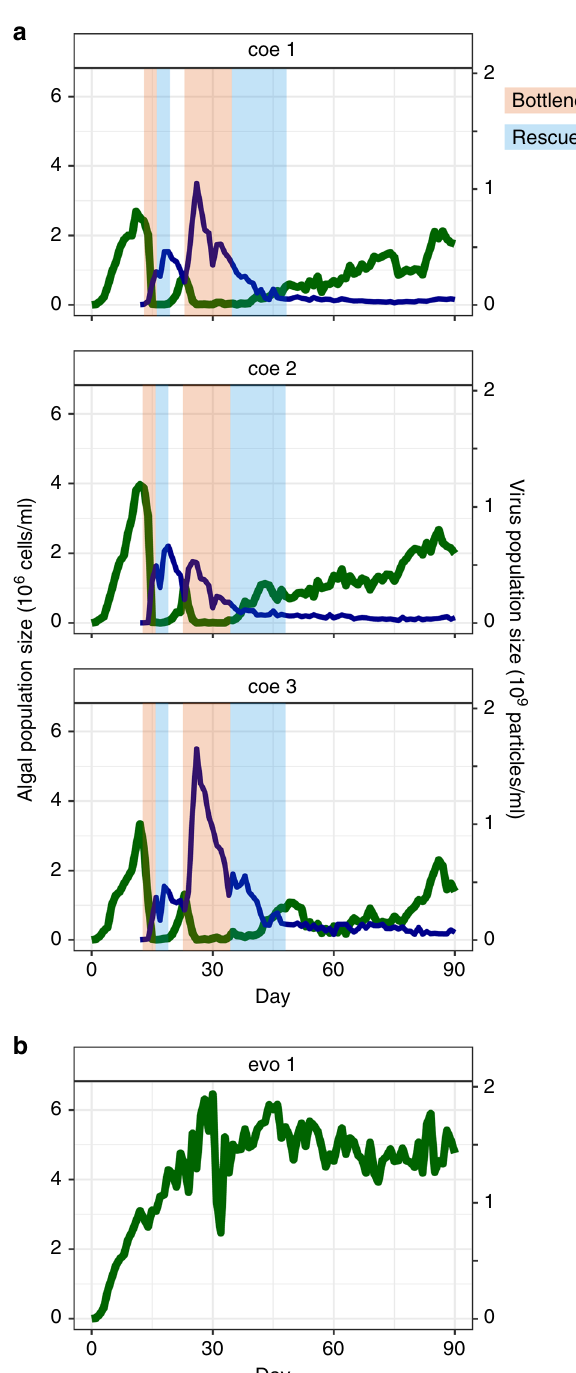
Fig. 1 Parallel changes in host population size. Dynamics of three replicate algal-virus (coevolved, a) populations and one population with only algae (evolved, b), from continuous cultures over 90 days. a Host population dynamics showed two bottlenecks (orange-shaded) followed by rapid expansions (bue-shaded) in each replicate. b Algal population increased to high densities followed by stable densities around carrying capacity. Only one out of three replicates is shown were maintained in the systems due to a trade-off between host resistance and growth rate 31 .